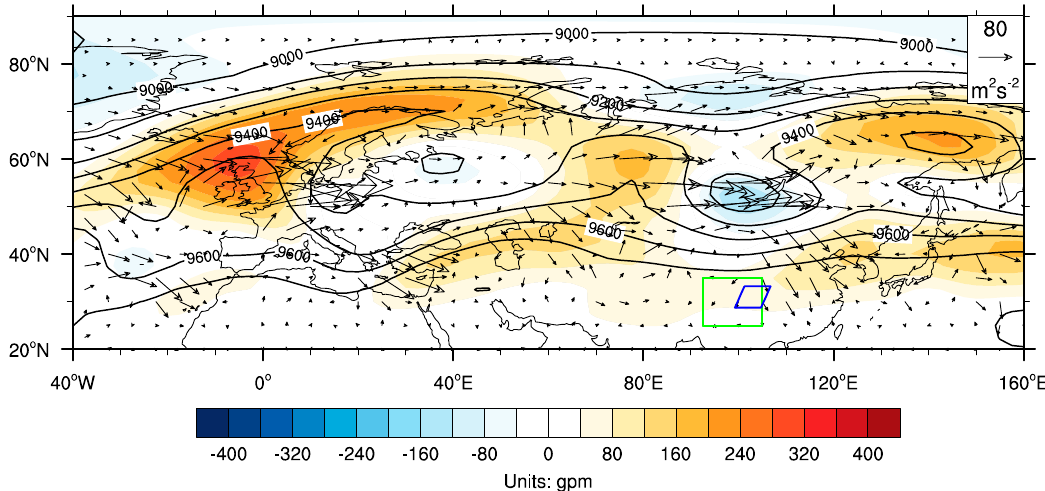
Figure 6. Same as Figure 4, but for the average over 7–11 July 2018.